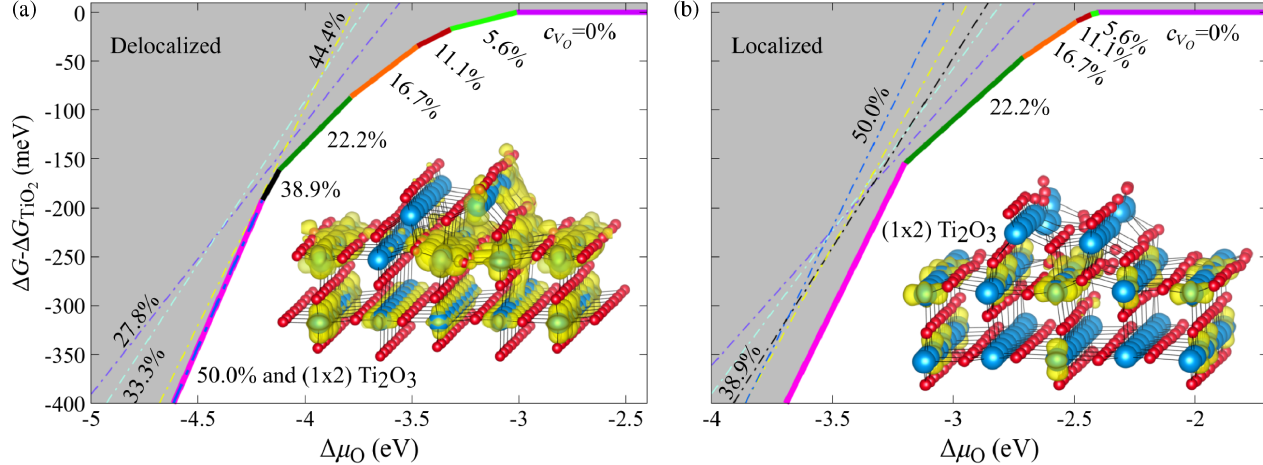
FIG. 4. TiO 2 ð 110 Þ surface phase diagram. Surface free energy ( Δ G ) for the most stable configurations obtained from the MD for the reduced ( 1 × 1 ) structures at different V concentrations (all lines except pink) and for the ( 1 × 2 ) Ti 2 O 3 reconstruction (pink line) as a O function of the chemical potential Δ μ with respect to the stoichiometric ( 1 × 1 ) phase. (a) Delocalized solution: Excess electrons are O ¼ 50 . 0% , the ( 1 × 1 ) structure is degenerate spread across all lattice sites and delocalized at the bottom of the conduction band. At c V O with the ( 1 × 2 ) Ti 2 O 3 reconstruction (Ti 2 O 4 with 50% of V ). (b) Localized solution: The excess electrons are trapped in distinct Ti O sites, mostly located in S 0 . The insets show the distribution of excess electrons in the ( 1 × 2 ) structure. The localized polaron picture is capable of predicting the ( 1 × 1 ) to ( 1 × 2 ) transition, manifested by the increased stability of the reconstructed Ti 2 O 3 phase at low oxygen chemical potential compared to the highly reduced ( 1 × 1 )